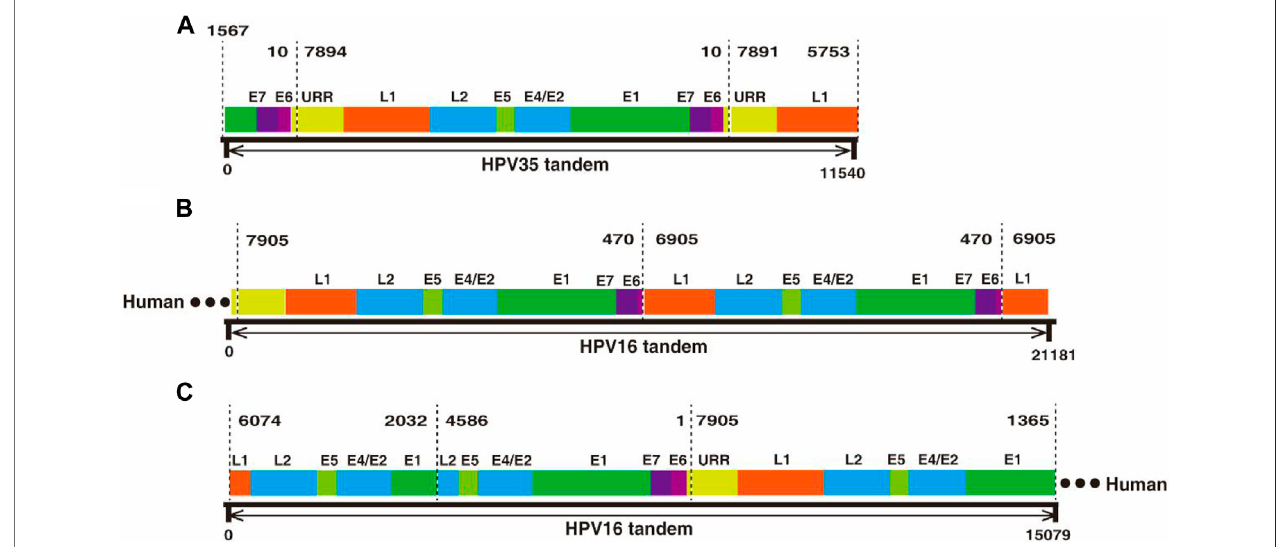
FIGURE 3 | Nanopore sequencing found tandem HPV genomes in cervical cancer tissues and CaSki cells, respectively. (A) An 11.54 kb-long HPV 35 tandem genomic